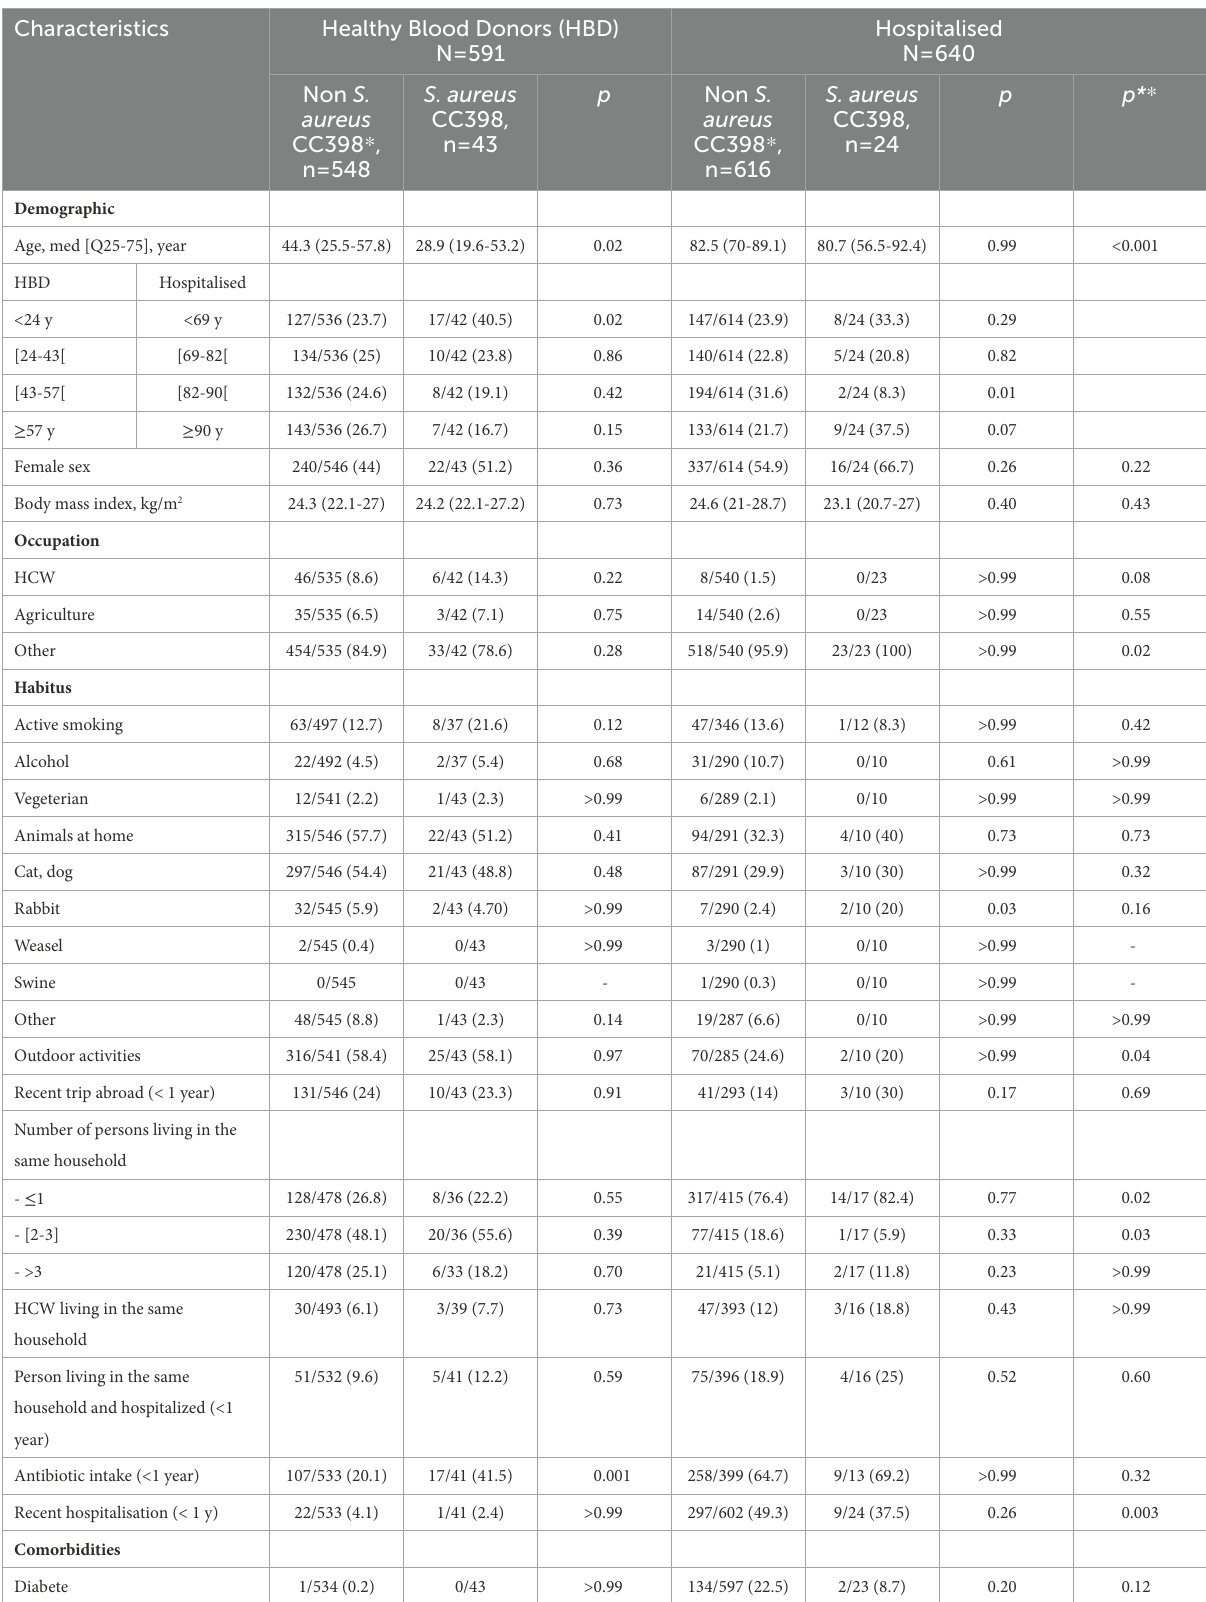
TABLE 2 Comparison of patients with nasal carriage of S. aureus CC398 with patients with nasal carriage of other clonal complex or no carriage of S. aureus.